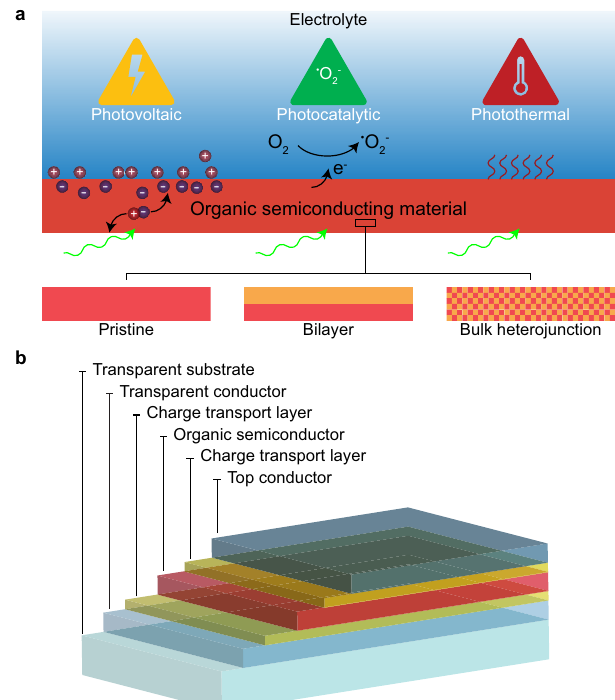
Fig. 1 Structure and function of organic interfaces. a Main processes occurring upon light absorption in organic semiconducting fi lms when immersed in electrolyte: photovoltaic, photocatalytic and photothermal conversions. The organic semiconducting layer can be a single pristine material or multiple materials in a bilayer or a bulk heterojunction. b Full layer-by-layer structure of a photovoltaic device for neuromodulation. The organic semiconductor can be interfaced directly to the electrolyte (as in a ) or paired to one (conductor/semiconductor interface) or two (conductor/ semiconductor/conductor interface) conductors working as the anode and cathode. Charge (hole and/or electron) transport layers can be used to enhance the stimulation ef fi